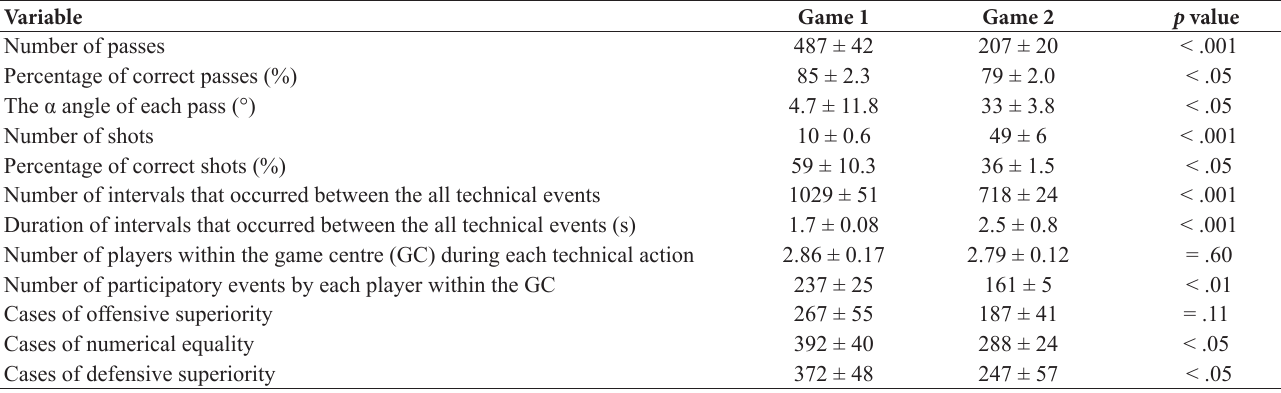
Table 2. Mean ± SD of each variable analysed in both games and their respective p